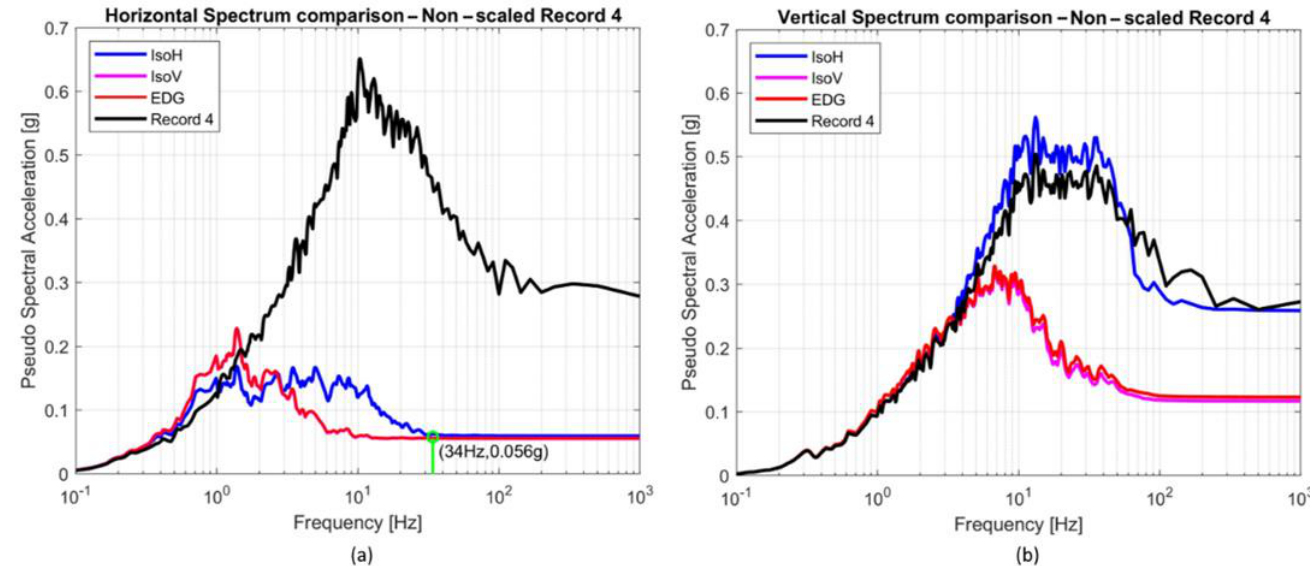
Figure 6. Spectral acceleration results for non-scaled Record 4. ( a ) Horizontal direction “X”; ( b ) Vertical direction “Z”.